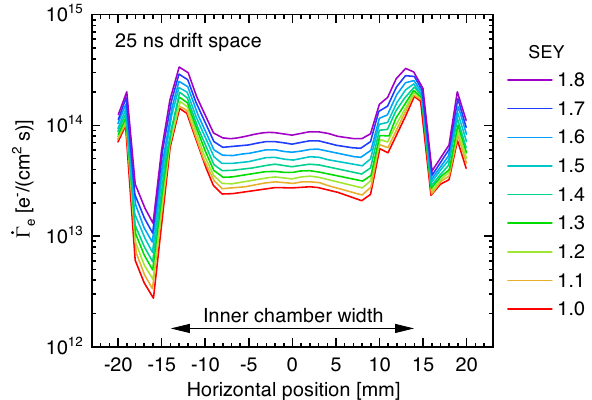
FIG. 7. Electron density graphs for an LHC-type BS and SEY curves Cu-like, for baseline parameters. On the left, BS in a dipole magnetic field, on the right in a quadrupole magnetic field. Figure taken from [7].